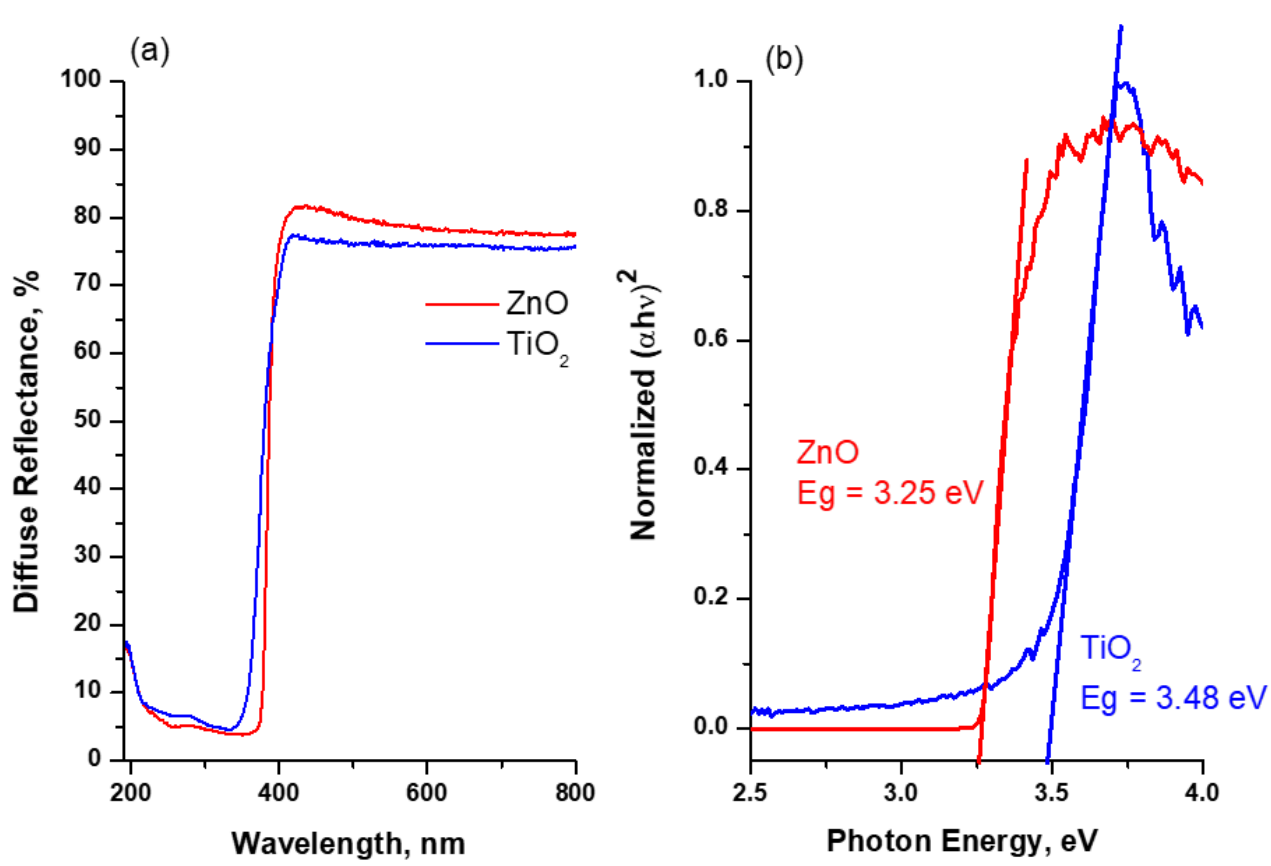
Figure 4. ( a ) Diffuse reflectance UV-vis spectra and ( b ) Tauc’s plot of ZnO and TiO 2 .